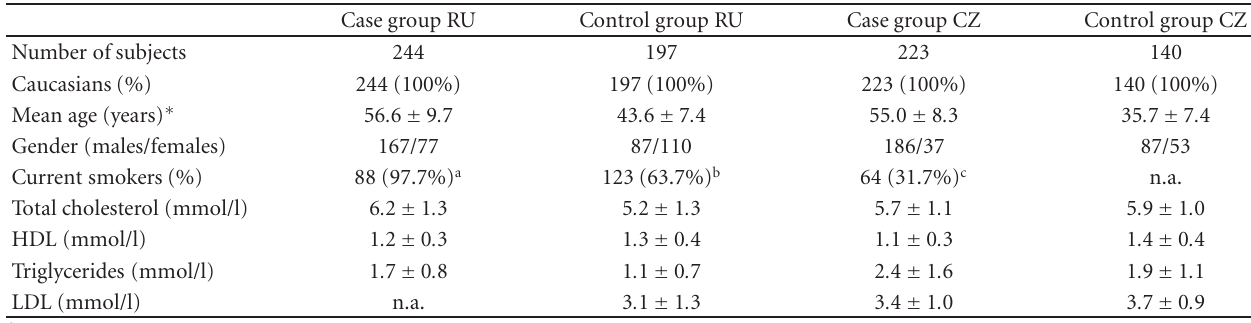
Table 1: Demographic and clinical characteristics of the study groups (MI patients and control subjects).